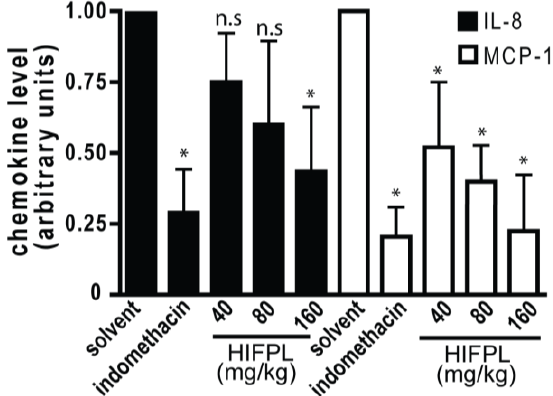
Figure 6. Effect of HIFPL on MCP-1 and IL-8 levels in carrageenan-induced paw edema in mice. HIFPL was tested at 40, 80 and 160 mg/kg (oral administration) and indomethacin (5 mg/kg, oral administration) was used as a reference drug. The values are mean ± standard errors. * p < 0.05; ** p < 0.01; n.s.: not significant (ANOVA/Dunnett), compared to the solvent-treated group.